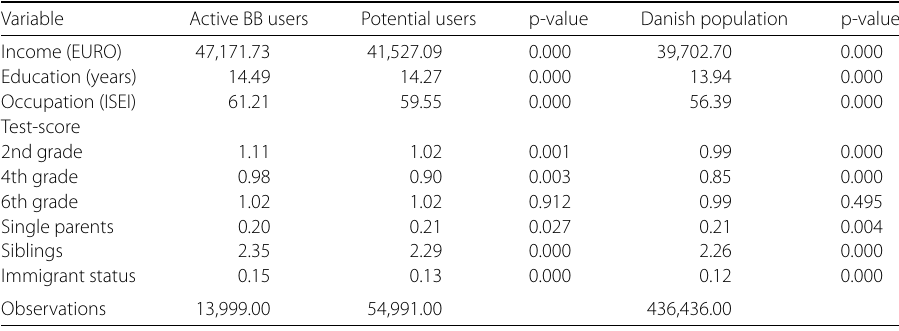
Table 1 Comparison of means; BB-users included in analytic sample vs. BB-users in total vs. country population